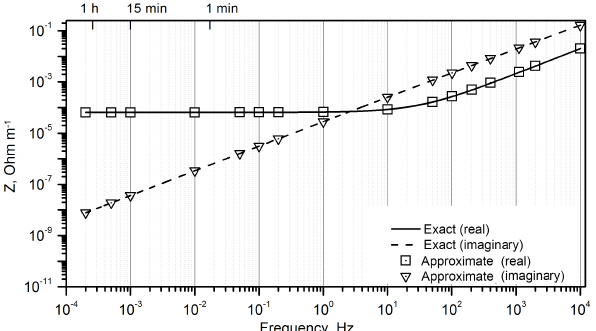
Figure 10. The frequency dependence of impedance of the transmission line wire, for external media with conductivity 10 − 14 Sm − 1 calculated by exact (lines) and approximate (scatter)